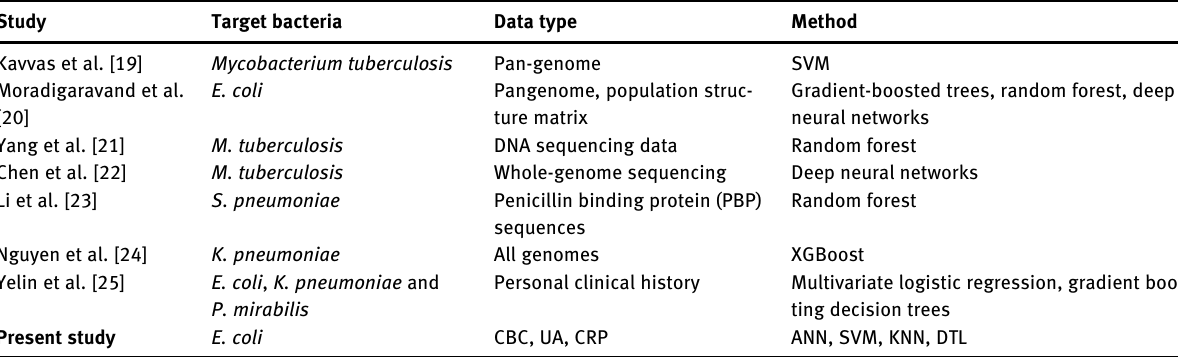
Table  : Studies investigating antibiotic resistance by machine learning systems.